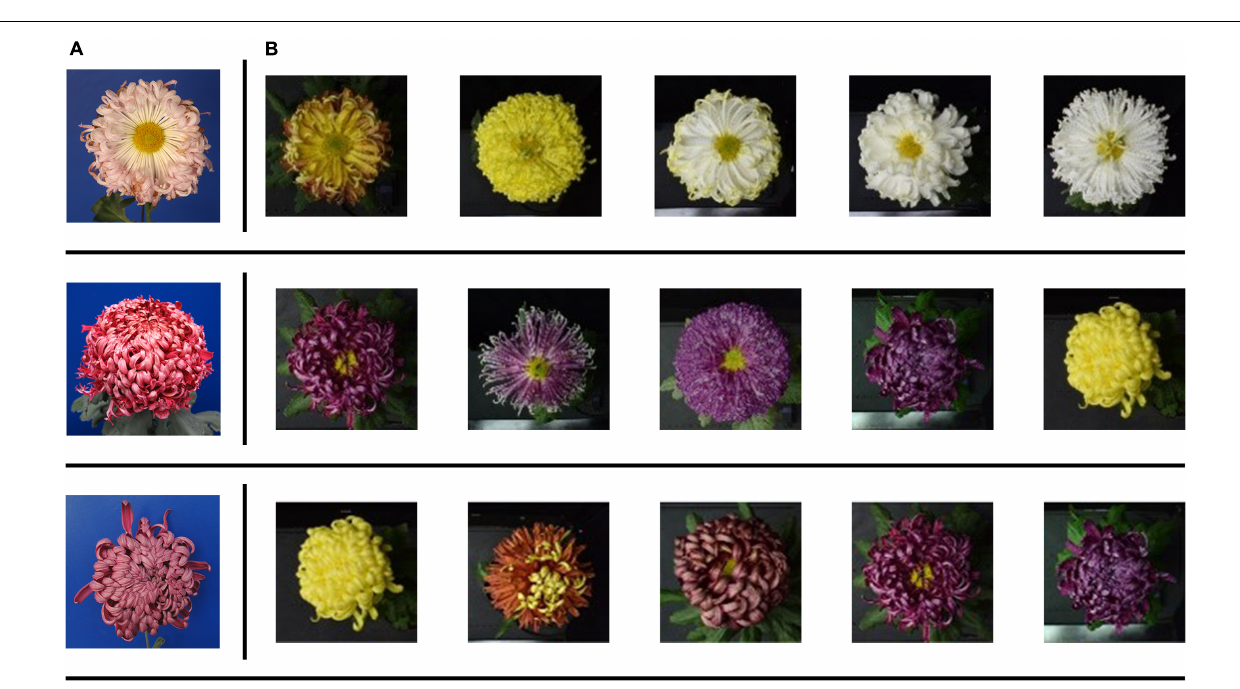
in 2018 (as shown in Supplementary Table 1 ) and 117 cultivars in 2019 (as shown in Supplementary Table 2